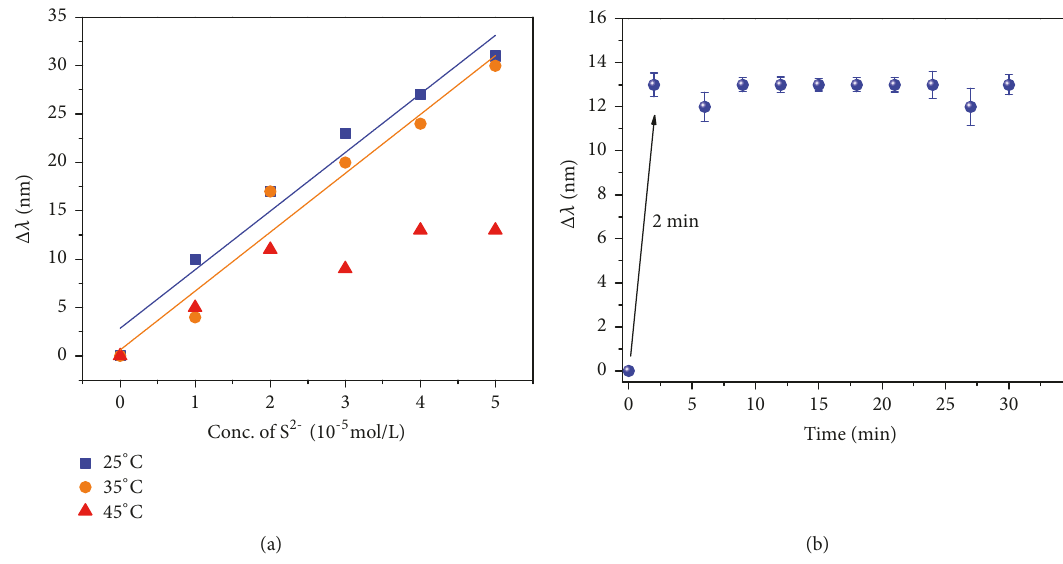
Figure 6: The effect of (a) detection temperature and (b) time on Δ𝜆 of the Au-HgNRs sensing system for S 2− .